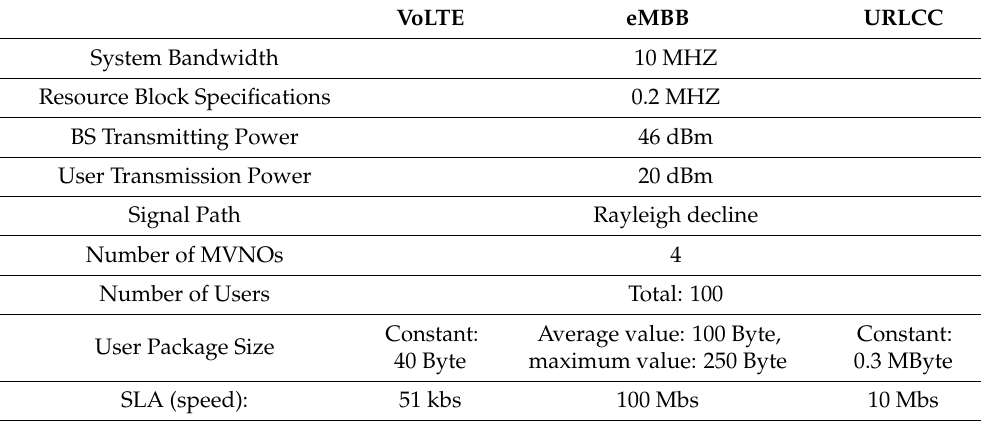
Table 2. Parameter settings for each service